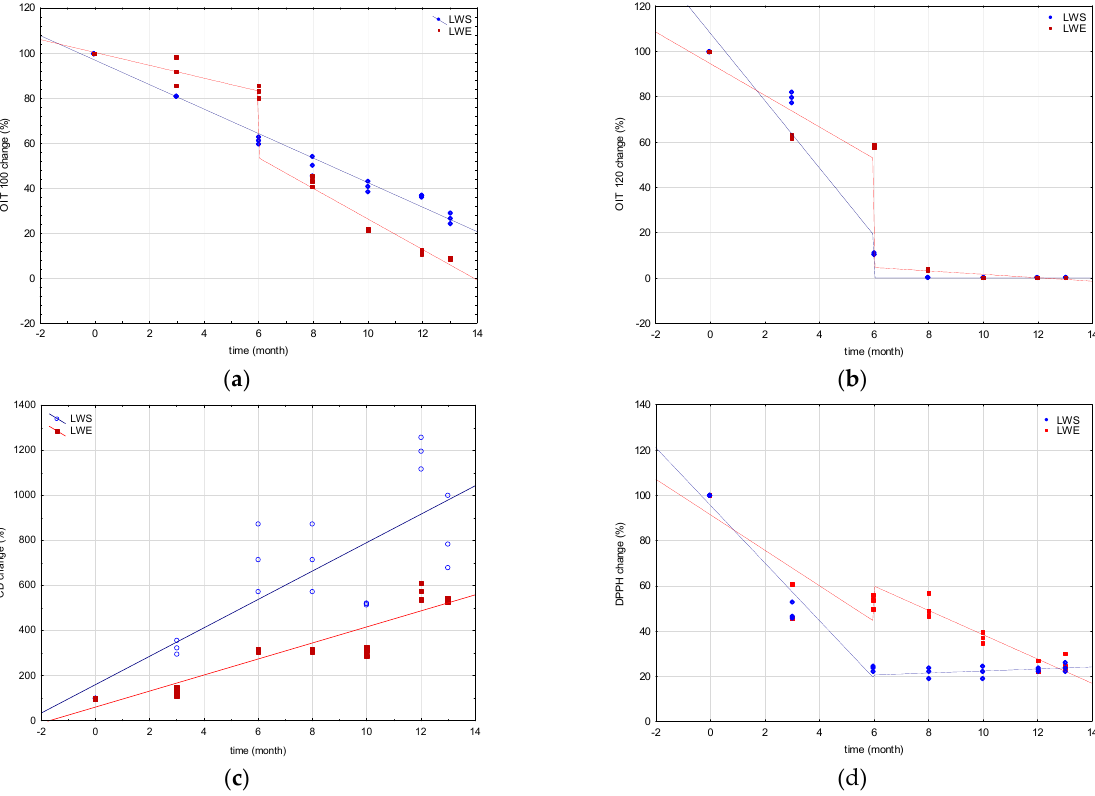
Figure 6. Changes (in %) of ( a ) DSC OIT index measured at 100 °C, ( b ) DSC OIT index measured at 120 °C, ( c ) diene concentration (CD) and ( d ) the antioxidant activity (DPPH) in time. When showing the data as %, it enables comparison of the results between various parameters. For the OIT (OIT100 and OIT120) and DPPH values, segmented regression (piecewise regression) was applied. The breakpoint was set at 6 months. The regression coefficients are shown in Table 2. Table 2. Regression coefficients ( β ) calculated for changes of the parameters (OIT100, OIT120, CD and DPPH) in time.